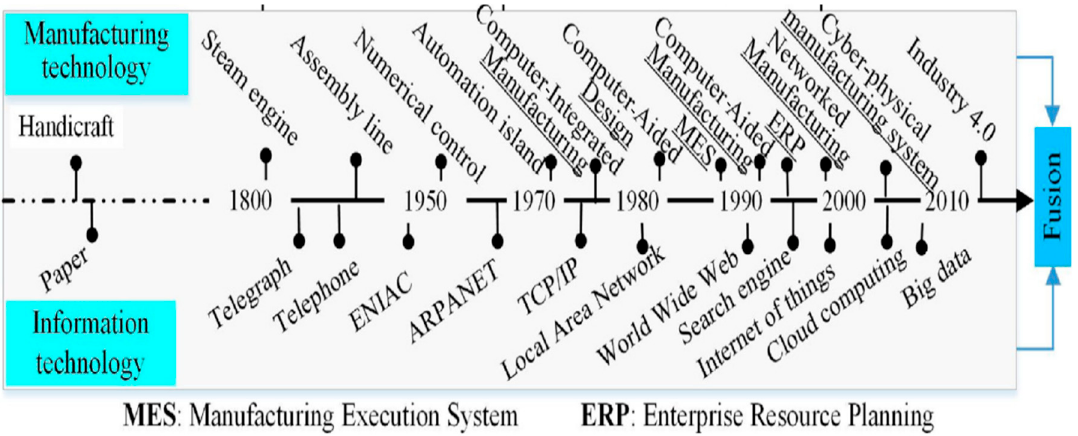
Figure 1. Illustration of changes in manufacturing and information with time [36].